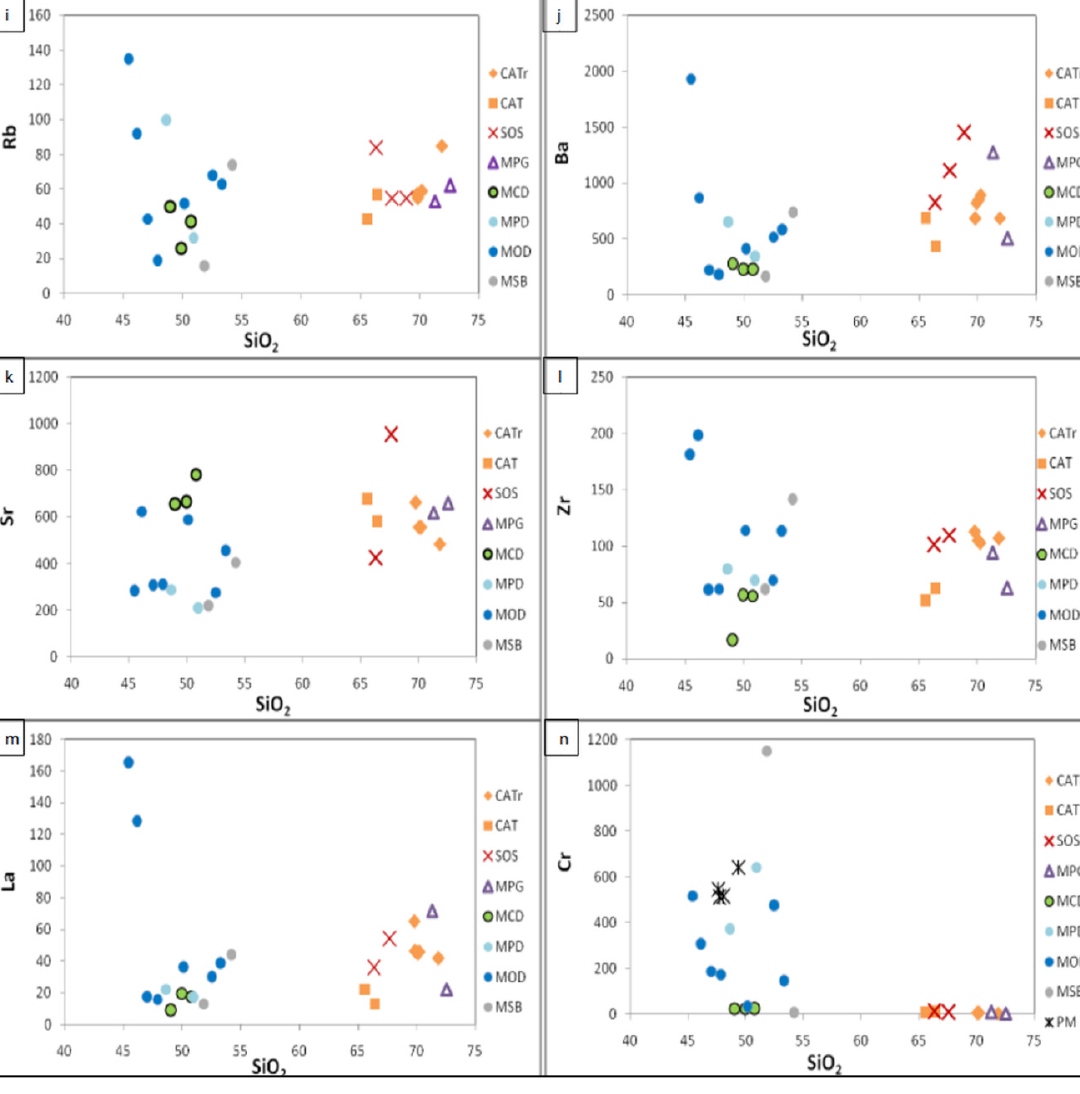
Figure 10. Harker diagrams for Corno Alto–M. Ospedale samples. ( a – h ) Major elements ( i – n ) Trace elements and REE. Symbols as in Figure 8.